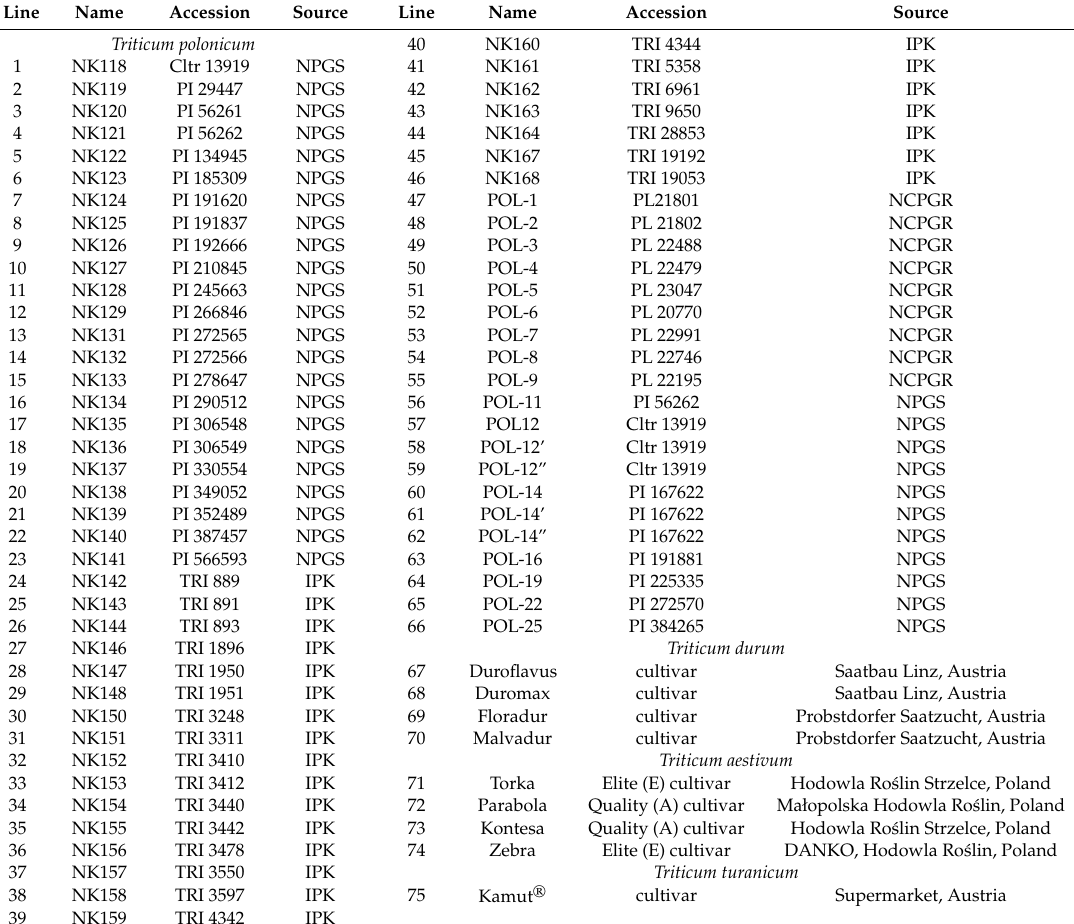
Table 1. Lines and cultivars of Triticum spp. examined in the